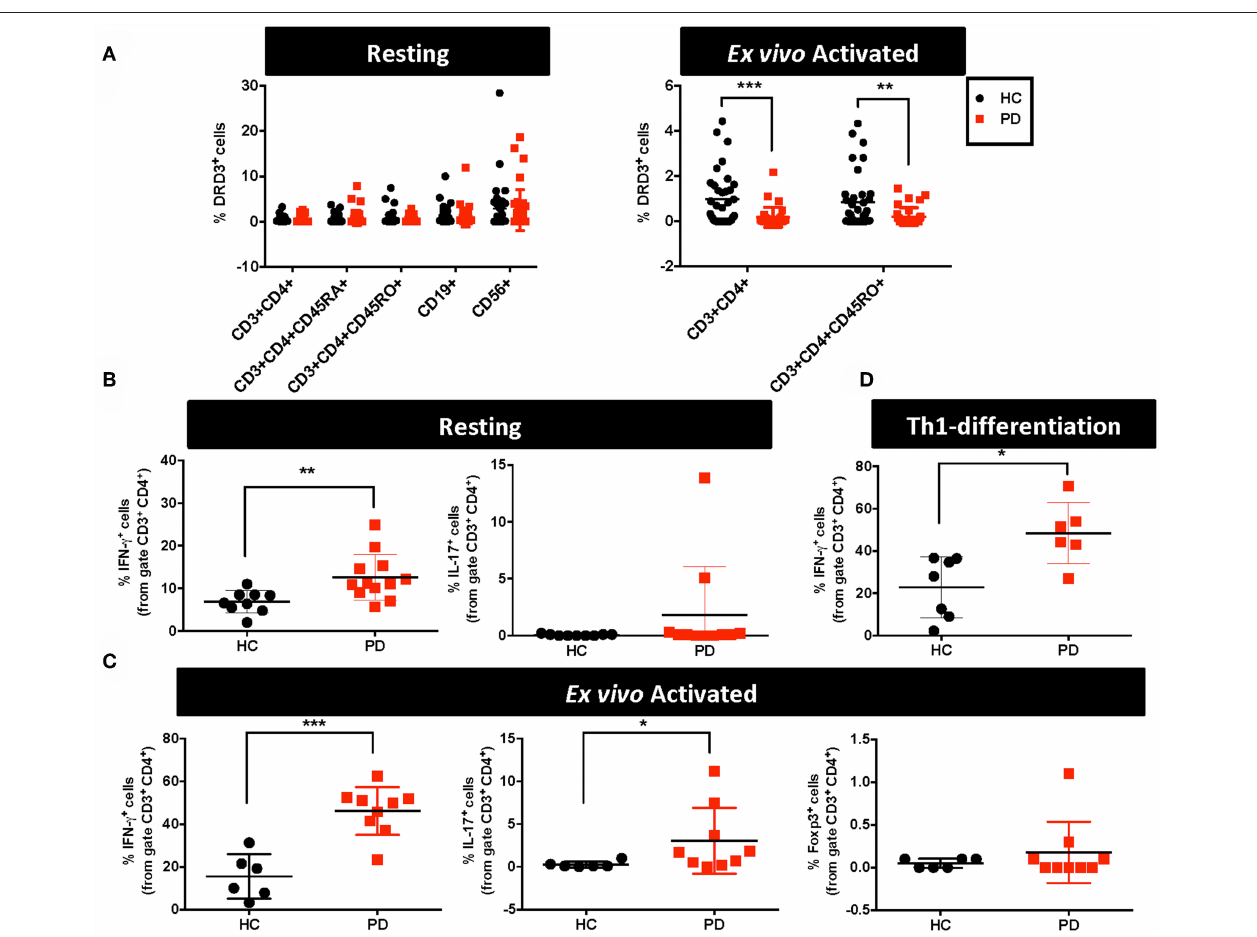
FIGURE 1 | Alterations in the functional phenotype and DRD3 expression in CD4 + T-cells obtained from Parkinson’s disease patients. (A–C) PBMCs were isolated from healthy donors (HC) and Parkinson’s Disease patients (PD) and they were immediately analysed or activated with anti-CD3 and anti-CD28 antibodies for 72h. (A) Cells were immunostained for several surface markers and DRD3 expression was analysed in different lymphocyte populations by flow cytometry. Left panel shows the frequency of DRD3 + cells in total CD4 + T-cells (CD3 + CD4 + ), naïve CD4 + T-cells (CD3 + CD4 + CD45RA + ), memory CD4 + T-cells (CD3 + CD4 + CD45RO + ), B-cells (CD19 + ), and NK cells (CD56 + ) in resting conditions. Right panel shows the frequency of total CD4 + T-cells (CD3 + CD4 + ) and memory/effector CD4 + T-cells (CD3 + CD4 + CD45RO + ) after T-cell activation. Two-tailed unpaired Student t -test was used for comparisons between HC ( n = 38) and PD ( n = 41). ** p < 0.01; ***, p < 0.0001. (B) Resting T-cells or (C) T-cells activated with anti-CD3 and anti-CD28 antibodies for 72h were stimulated with PMA and ionomycin in the presence of brefeldin A for 4h and IFN- γ (left panels), IL-17 (middle panels), and Foxp3 (right panels) expression was determined by intracellular immunostaining in the CD3 + CD4 + gated population. Foxp3 + cells were undetectable in resting conditions. Two-tailed unpaired Student t -test was used for comparisons between HC [ n = 9 in (B) ; n = 6 in (C) ] and PD [ n = 11–12 in (B) ; n = 9 in (C)] . * p < 0.05; ** p < 0.01; *** p < 0.0001. (D) Naïve CD4 + T-cells (CD3 + CD4 + CD45RA + ) T-cells were isolated from PBMCs obtained from HC and PD individuals and then they were incubated in Th1-biased conditions for 5 days. Afterwards, cells were stimulated with PMA and ionomycin in the presence of brefeldin A for 3h and IFN- γ expression was determined by intracellular immunostaining in the CD3 + CD4 + gated population. Two-tailed unpaired Student t -test was used for comparisons between HC ( n = 7) and PD ( n = 6). * p <